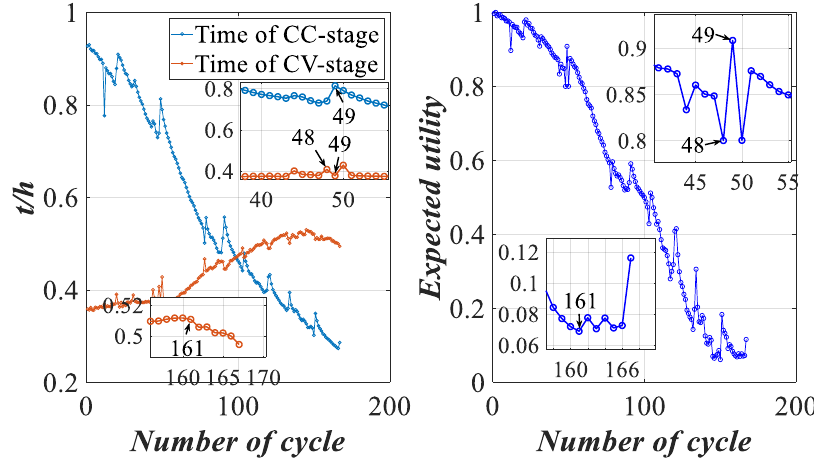
Figure 9. Local indicators and utility comparisons.